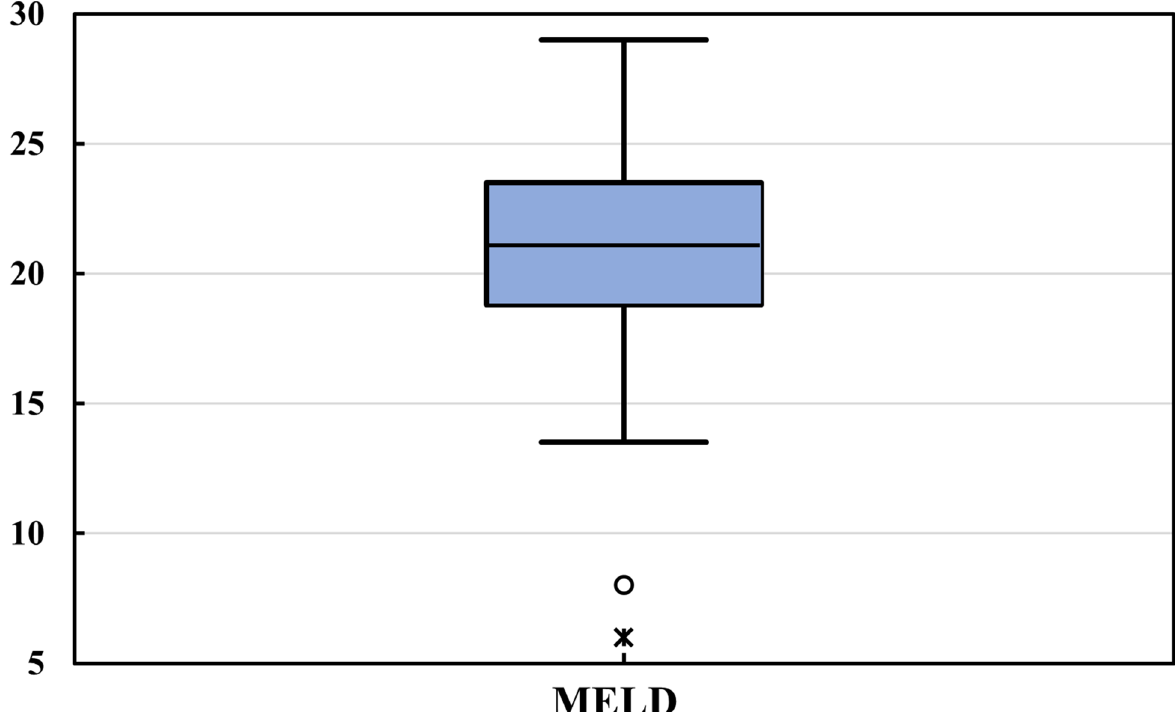
Fig. 5 MELD score assessment in the study Fig. 5 This figure showed that, the mean MELD was 18.8 and the range was from 6 to 29